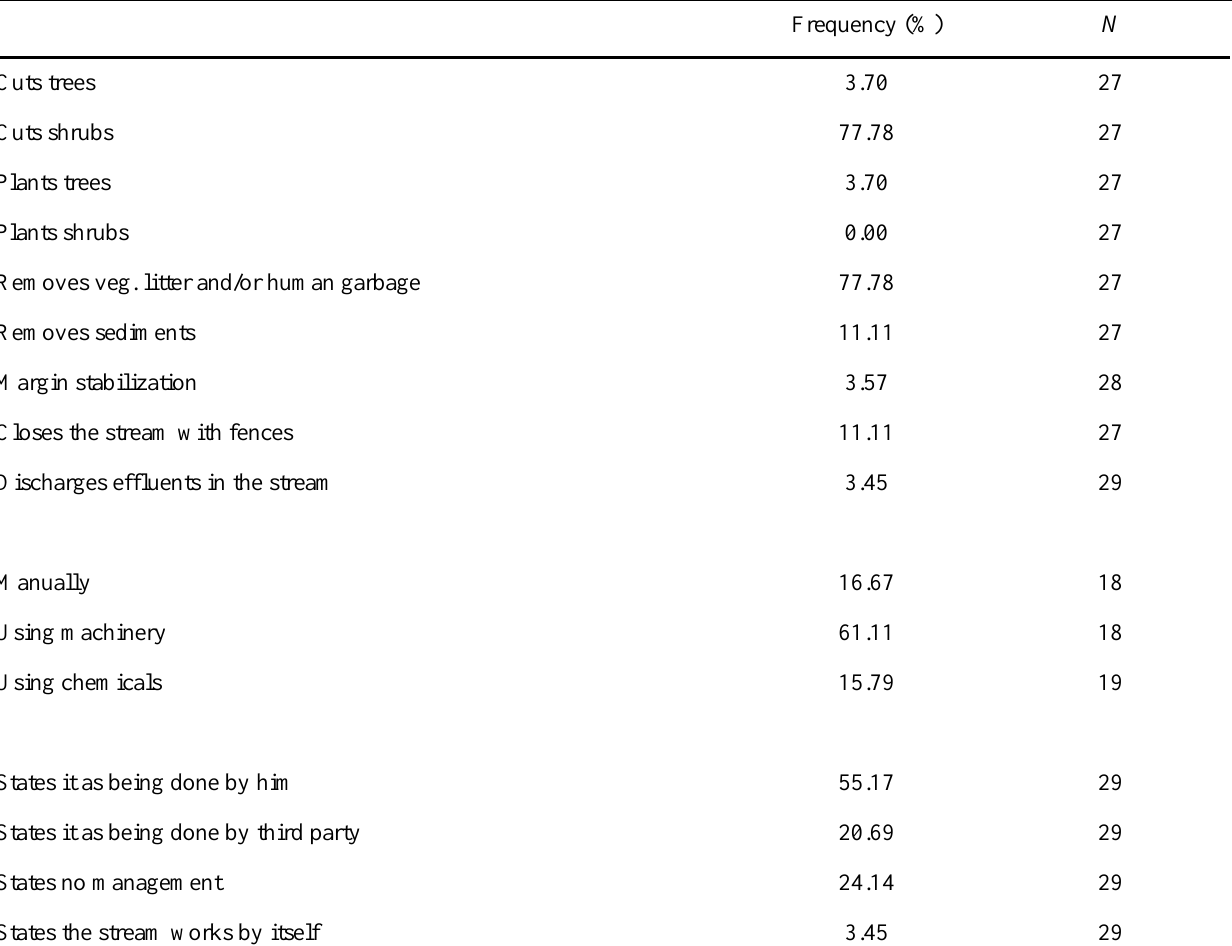
Table 3. Frequency of landholders’ stated practices in stream management. The table shows the frequency of each practice (identified by landholders) as well as the number ( N ) of interviews that provided valid information about that practice, from the 32 interviews